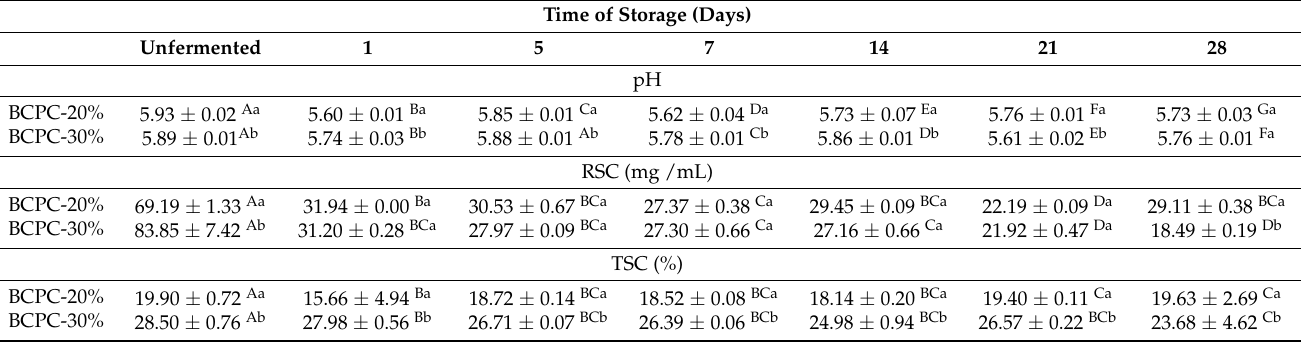
Table 1. The results of changes of pH, Reducing Sugar Content (RSC), and Total Solids Content (TSC) during